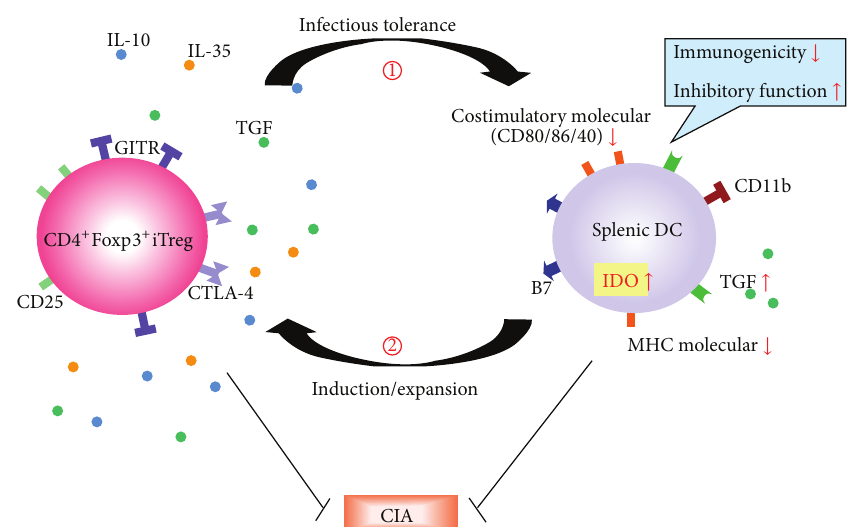
Figure6:ThecrosstalkbetweeniTregsandsplenicDCsinCIAmice.ThefeedbackloopgeneratedthroughcrosstalkbetweeniTregandsplenic DCs in vivo . Transferred iTregs induce a series of tolerogenic characteristics in splenic DCs, including the reduced costimulatory molecule expression, increased TGF- 𝛽 secretion, and reduced immunogenicity and effective inhibitory function. Furthermore, these tolerogenic DCs also exhibited protective effects on CIA. In addition, these DCs convert CD4 + Foxp3 − T cells into new Foxp3 + iTregs in vivo , which inherited the potential suppressive activity and maintained oral tolerance. Obviously, the long-term protection against CIA was influenced through the close relationship and continuous interaction of DCs and iTregs, termed “infectious